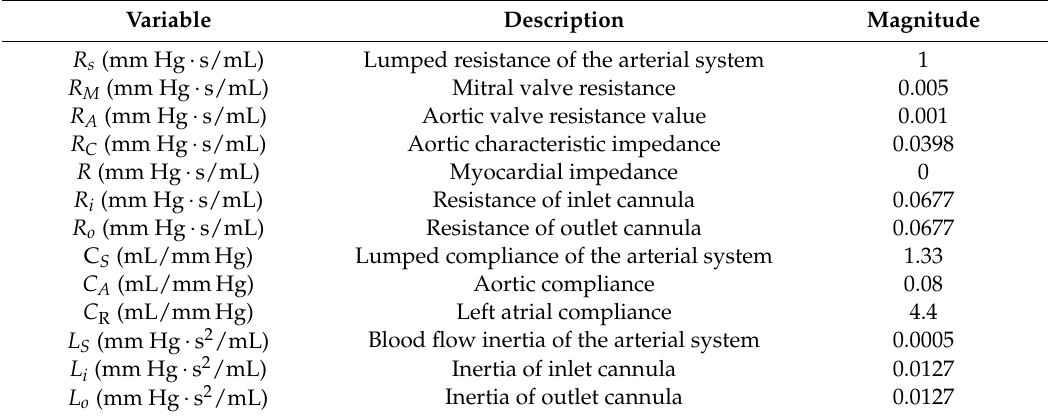
Table 3. Simulation model parameters of the cardiovascular